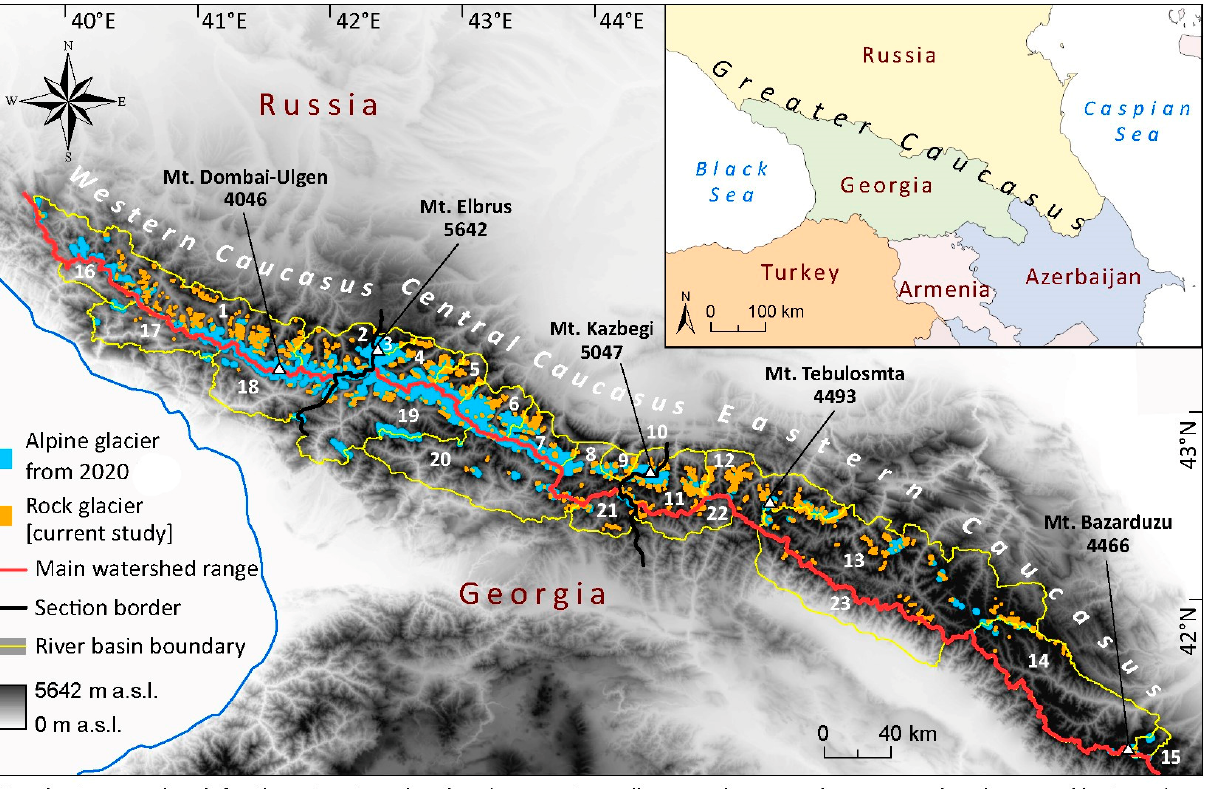
Figure 1. The extent of rock glaciers relative to alpine glaciers in the Greater Caucasus. The location of the Caucasus region is shown in the inset map at the top right. Peak elevations are given in meters above sea level [57].